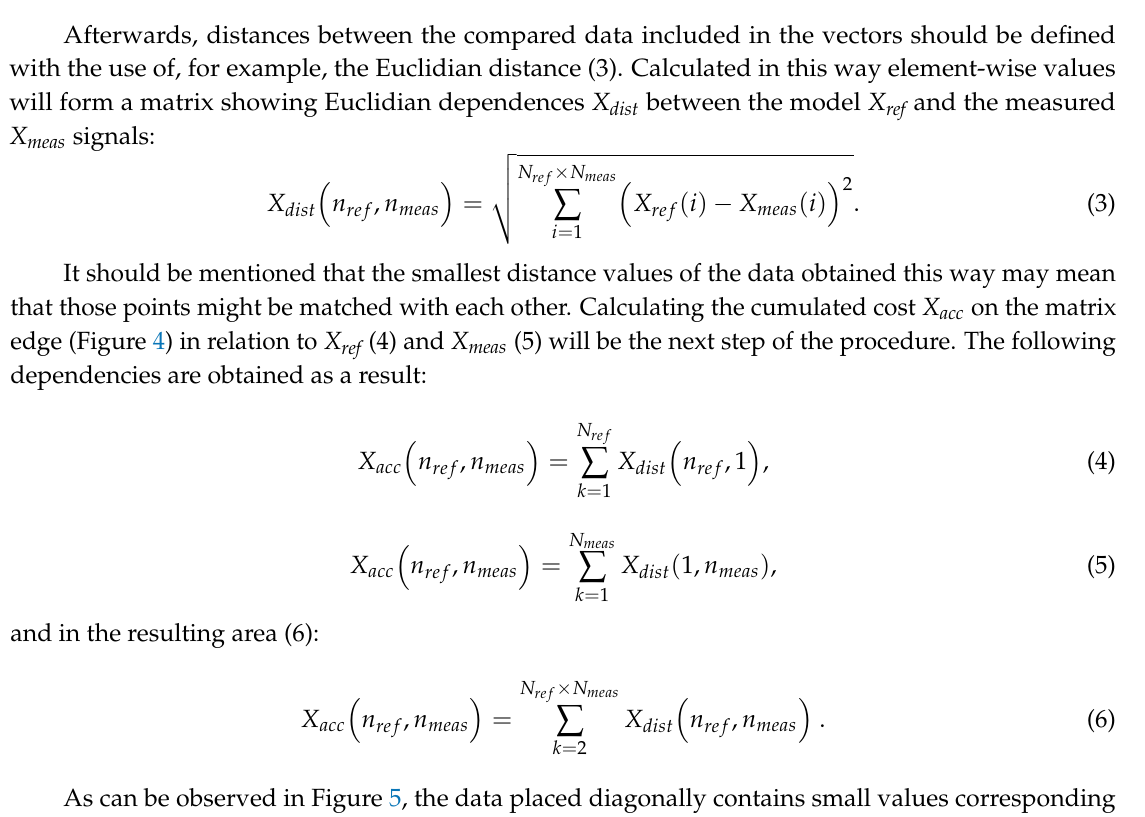
Figure 4. Visualization of the basic data structure and the operations exploited in the DTW (Dynamic Time Warping) algorithm.